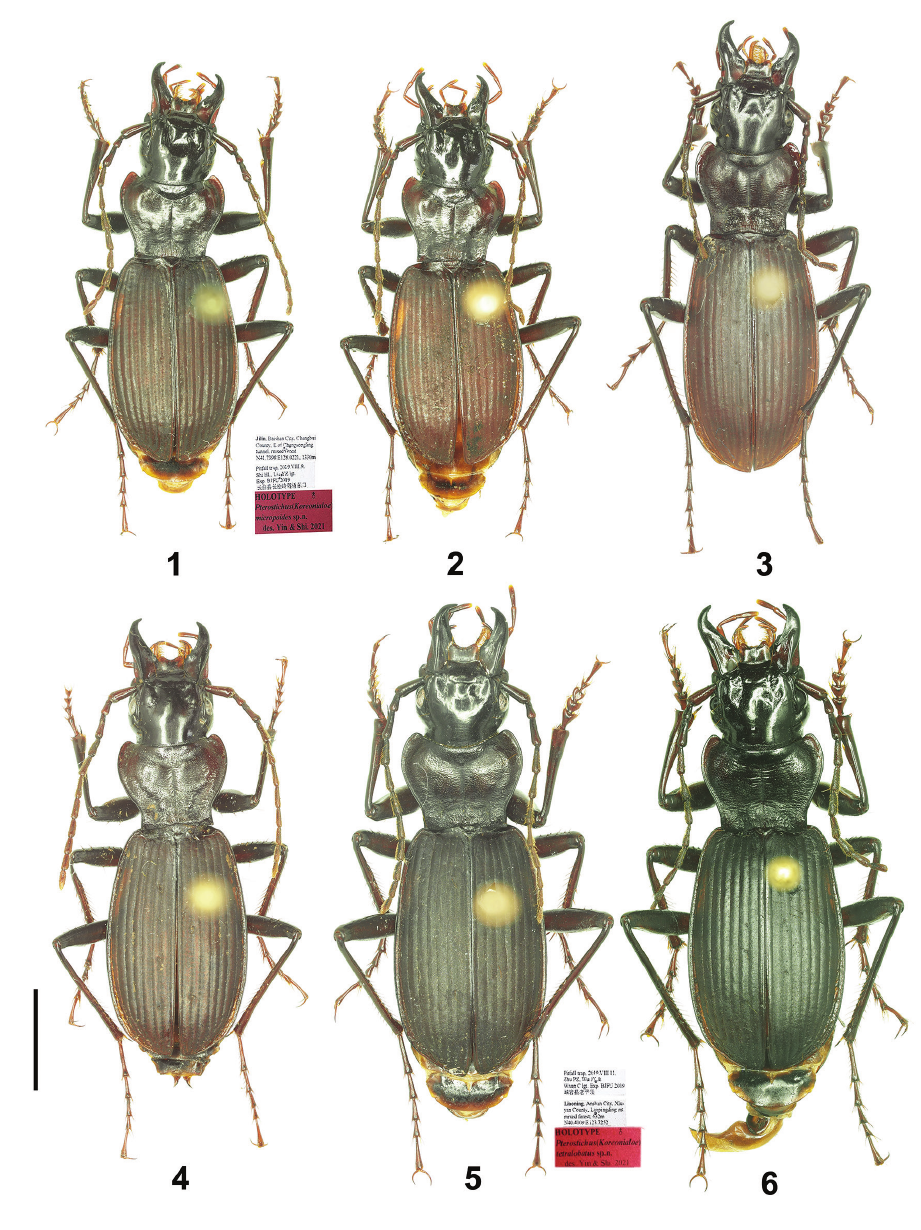
Figures 1–6. Habitus of Pterostichus (Koreonialoe) spp. from China 1 P. micropoides sp. nov., Holotype. 2 P. micropoides sp. nov., male, Paratype from Hunchun city, Jilin 3 P. syleus Kirschenhofer, a male